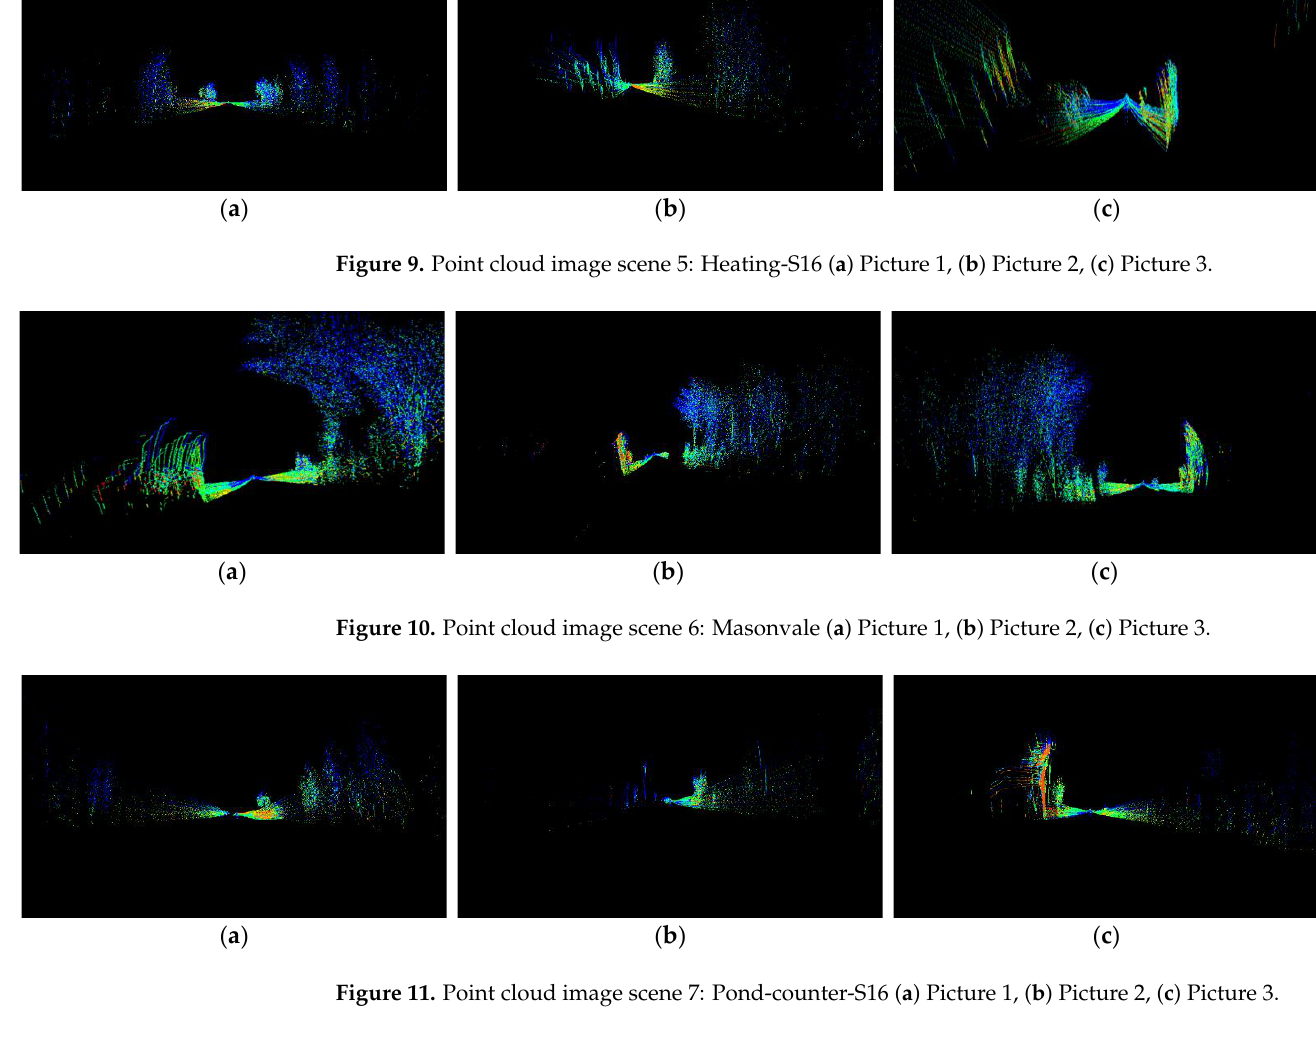
( c ) Figure 13. Point cloud image scene 9: Field-House-counter-S16 ( a ) Picture 1, ( b ) Picture 2, ( c ) Picture 3. ( a ) ( c ) Figure 14. Point cloud image scene 10: Mason-Hall-S16 ( a ) Picture 1, ( b ) Picture 2, ( c ) Picture 3. Figure 15. Intensity of point cloud map.